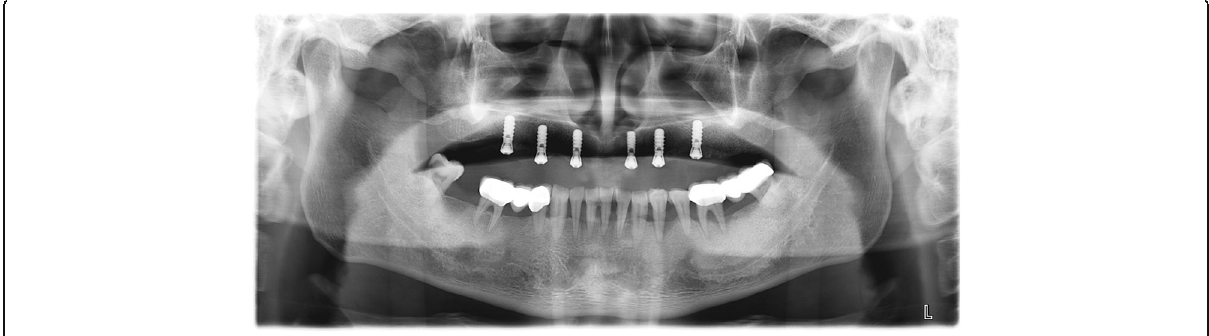
Fig. 7 Post-placement panoramic x-ray